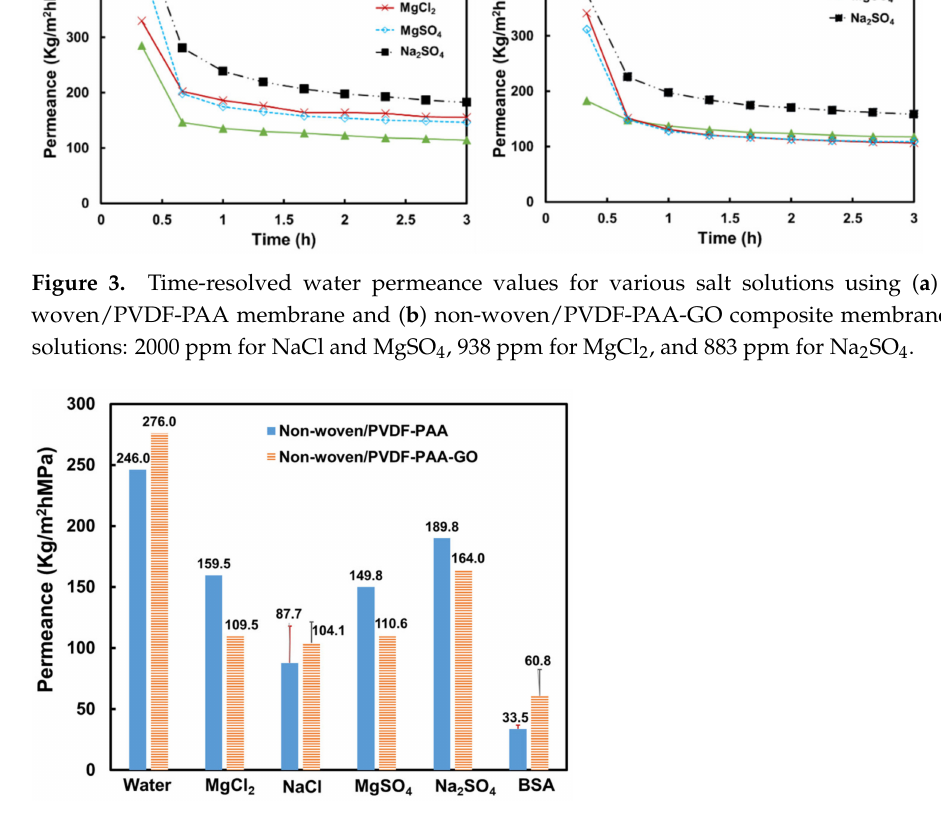
Figure 4. Steady-state water permeation of salt and BSA solutions using non-woven/PVDF-PAA and non-woven/PVDF-PAA-GO composite membranes. Salt solutions: 2000 ppm for NaCl and MgSO 4 , 938 ppm for MgCl 2 , and 883 ppm for Na 2 SO 4 ; BSA solution: 500 ppm. The values of NaCl and BSA are the mean ± 95% confidence intervals based on two replicates (n = 2).